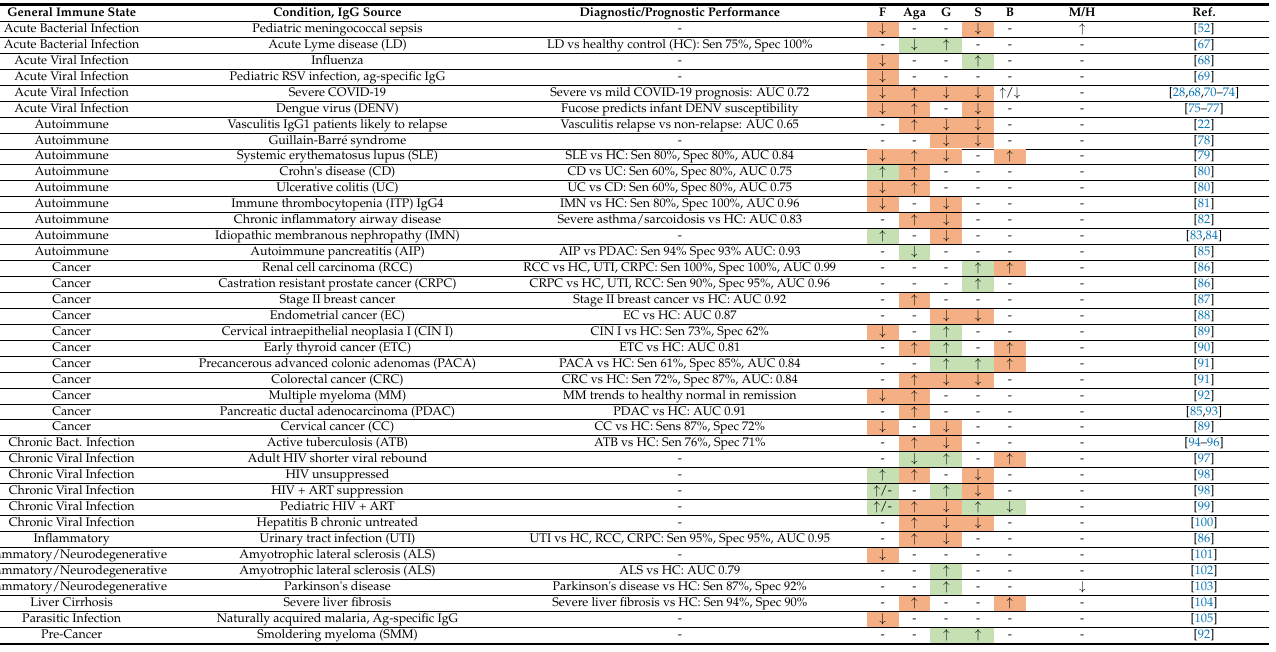
Table 1. IgG N-glycan Profile Trends and Diagnostic Performance. F = core-fucose, Ag = Agalactose, G = Galactose, S = Sialic Acid, B = Bisecting, and M/H = Mannose/Hybrid N-glycans. Up and down arrows indicate if the glycan class is increased or decreased during the disease state. An arrow and a dash indicate an increase or no change while up and down arrows separated by a slash indicates specific glycans within the class increased while others decrease. Orange coloration indicates a proinflammatory effector function while green coloration indicates an anti-inflammatory effector